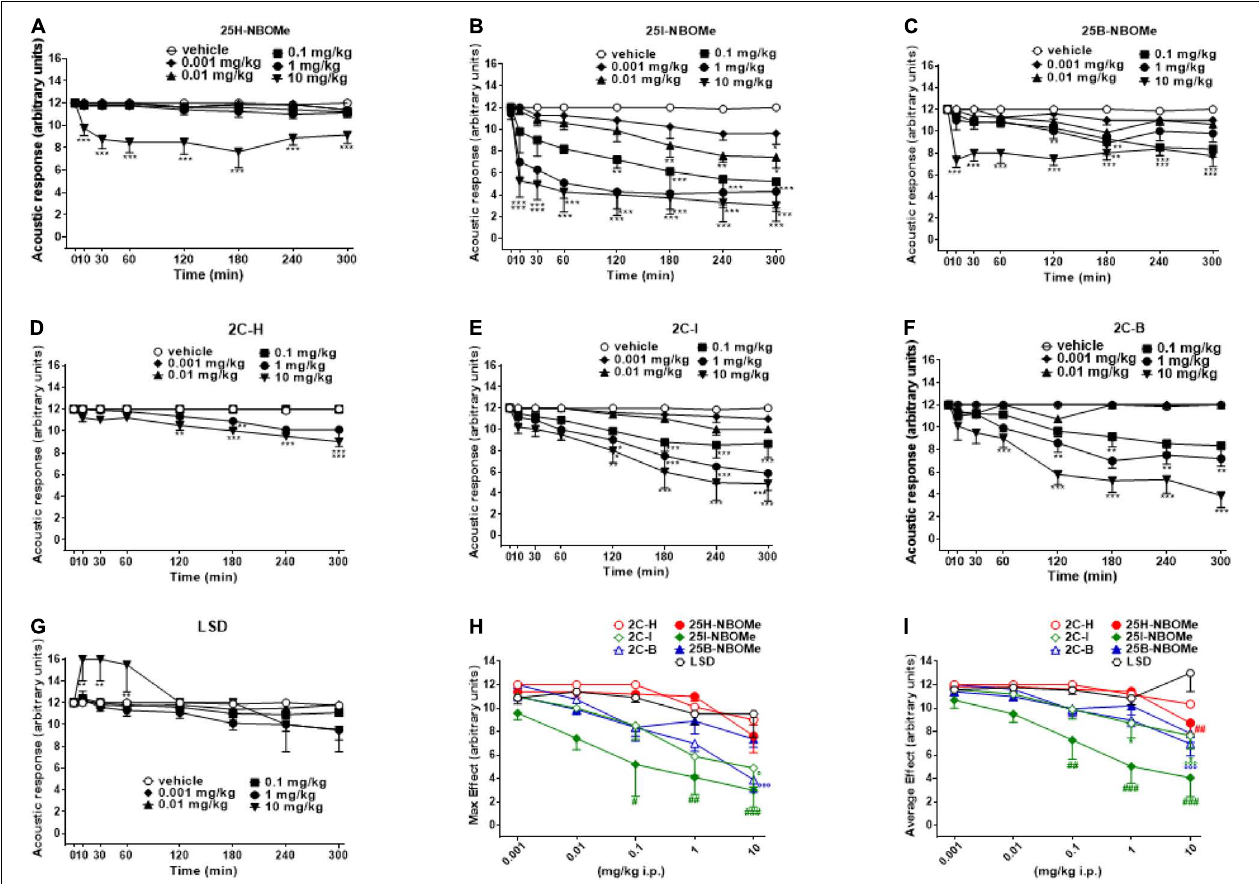
FIGURE 4 | Effect of 25H-NBOMe (0.001–10 mg/kg i.p.) (A) 25I-NBOMe (0.001–10 mg/kg i.p.) (B) 25B-NBOMe (0.001–10 mg/kg i.p.) (C) 2C-H (0.001–10 mg/kg i.p.) (D) 2C-I (0.001–10 mg/kg i.p.) (E) 2C-B (0.001–10 mg/kg i.p.) (F) , and LSD (0.001–10 mg/kg i.p.) (G) on the acoustic tests in mice and comparison of the maximum (H) and average (I) effects observed in 5 h. Data are expressed as mean ± SEM ( n = 8/group). Statistical analysis was performed by two-way ANOVA followed by Bonferroni’s test (A–G) for multiple comparisons for the dose–response curve of each compound at different time points. The comparison of maximum effect observed in 5 h was also presented (H,I) . * p < 0.05, ** p < 0.01, *** p < 0.001 vs. vehicle; # p < 0.05, ## p < 0.01, ### p < 0.001 vs.